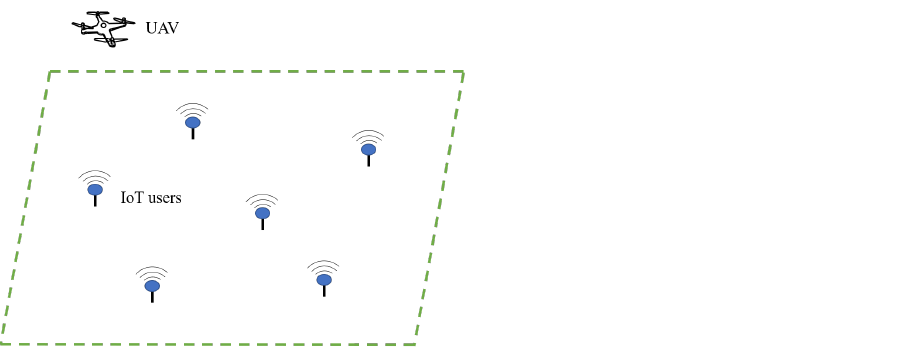
Figure 5. A quadrotor UAV is employed to collect data from a group of K IoT users in a UAV-assisted wireless communication